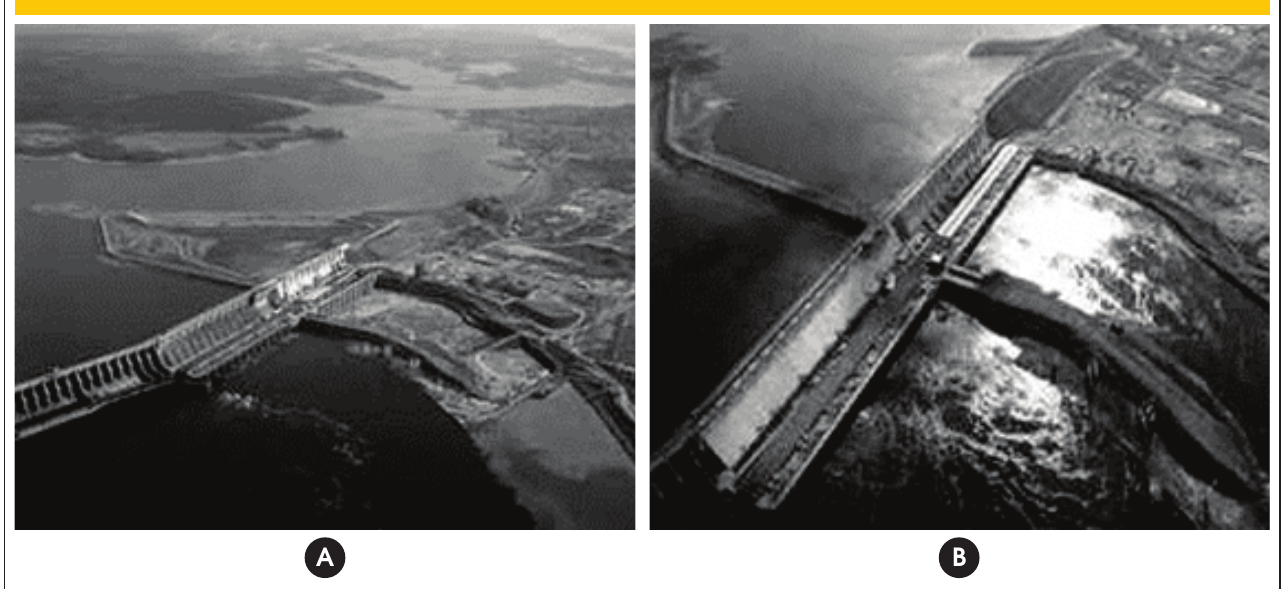
Figure 7 – Aerial views of the UHE Tucuruí dam. (a) Construction of the second stage, with cofferdams still present. (b) After completion of the second stage, where the cofferdams were demolished (SOURCE: